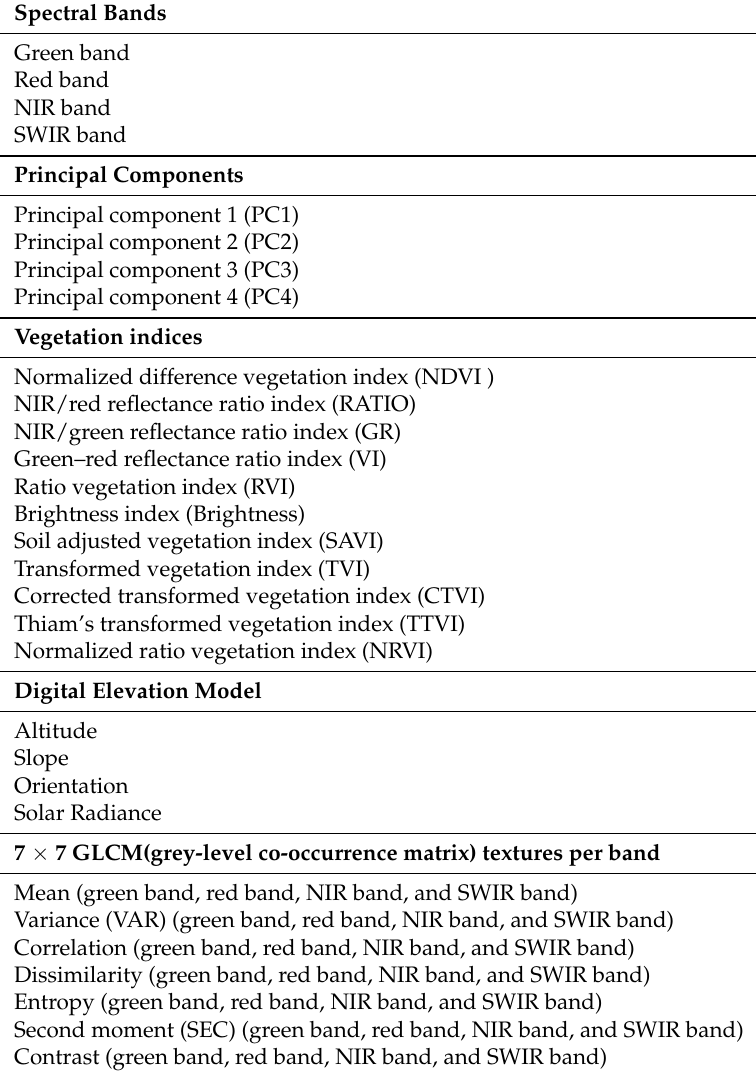
Table A1. Independent variables generated from the SPOT-5